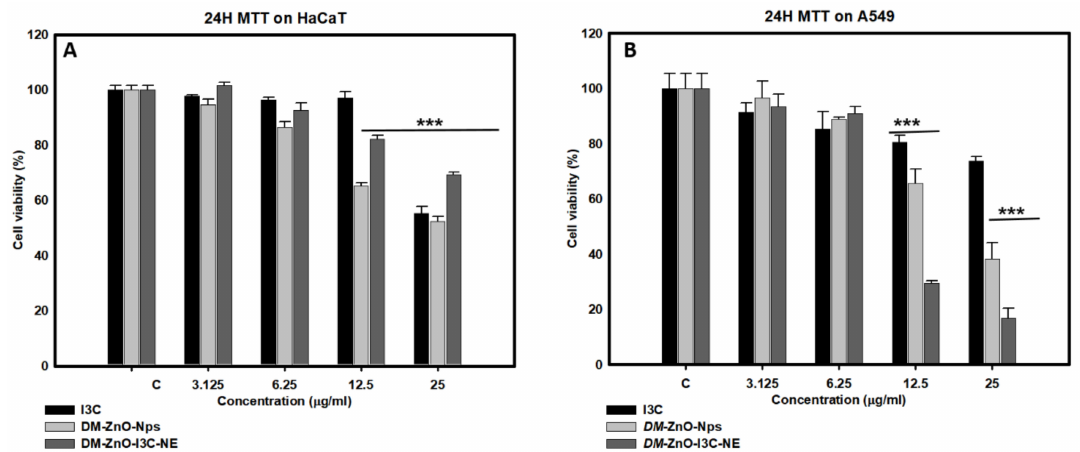
Figure 8. In vitro cytotoxicity analysis for I3C, DM -ZnO NPs, and DM -ZnO-I3C-NE nanoemulsion in ( A ) Human keratinocyte cells (HaCaT) and Human lung carcinoma (A549) cells ( B ). Each value is expressed as the mean ± standard error of three independent experiments. *** p < 0.001 compared with